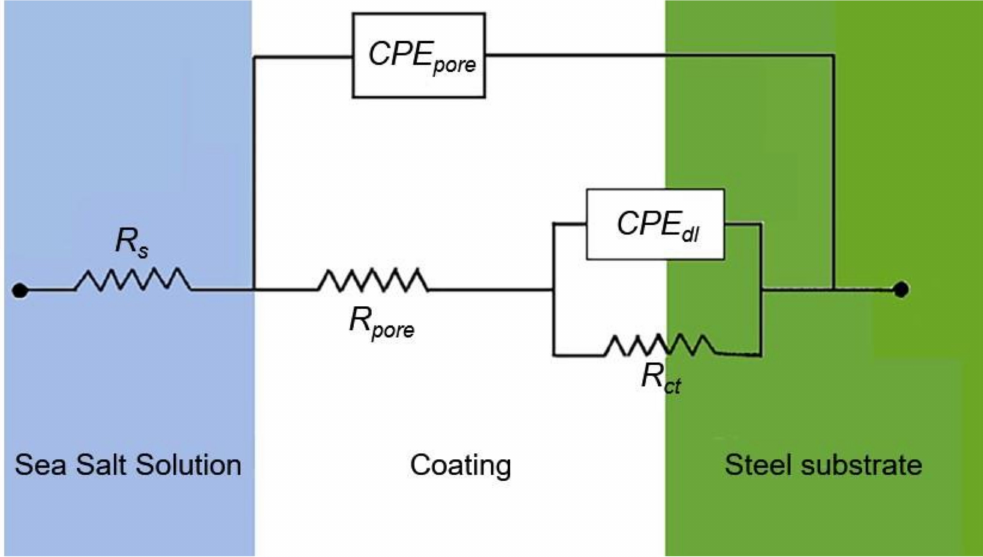
Figure 9. Electrochemical equivalent circuit (EEC) from the EIS